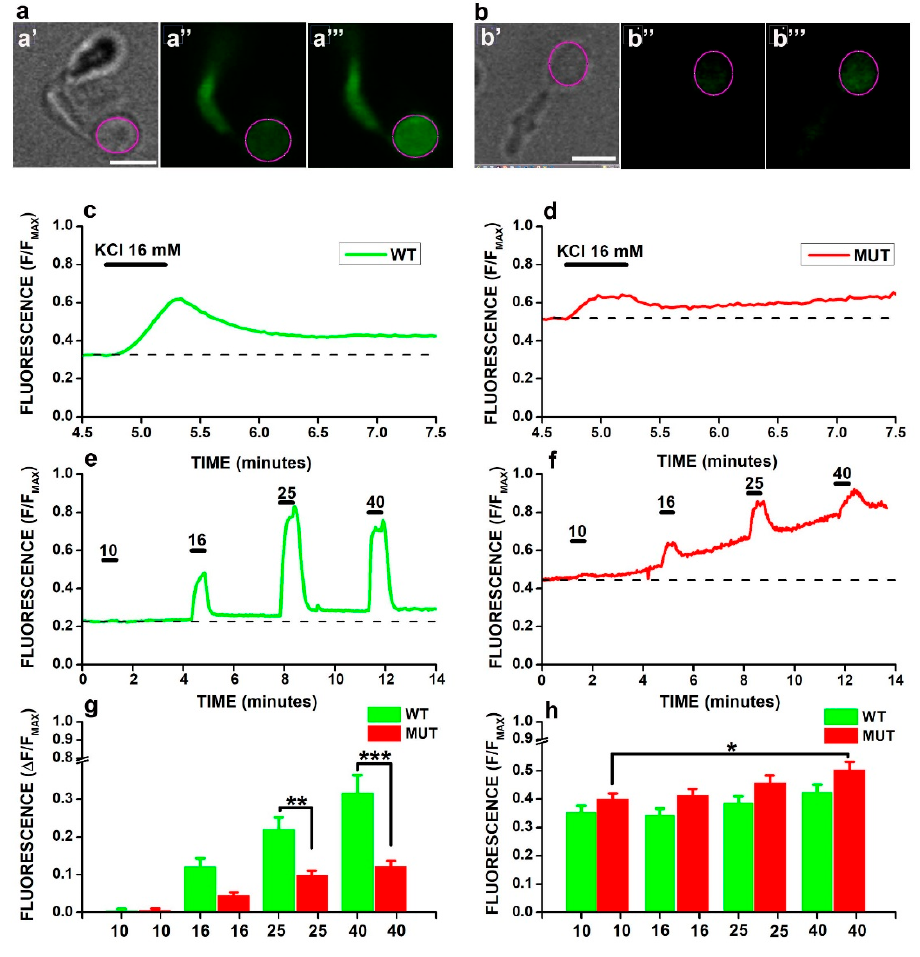
Figure 2. ( a , b ) Transmitted light images of isolated WT ( a (cid:48) ) and MUT ( b (cid:48) ) rods and Fluo-4 fluorescence in 3.6 and 16 mM KCl for a WT ( a (cid:48)(cid:48) , a (cid:48)(cid:48)(cid:48) ) and a MUT ( b (cid:48)(cid:48) , b (cid:48)(cid:48)(cid:48) ) rod, respectively. Calibration bars in a (cid:48) and b (cid:48) correspond to 5 µ m and hold for a and b panels, respectively. Magenta circles in a and b indicate the Region Of Interest (ROI) for fluorescence analysis. ( c , d ) Time-course of normalized fluorescence (F/F MAX ) over the region-of-interest of the cell body (magenta circles in ( a , b )) during a 30 s-long application (thick bars above records) of saline containing 16 mM KCl (black marks above records) for the WT ( c ) and the MUT ( d ) rod. Following exposure to 16 mm KCl, the F/F MAX value of WT and MUT rods did not recover to their baseline levels (dashed traces). ( e , f ) F/F MAX changes induced in the WT ( e ) and MUT ( f ) rods above by the application of saline with increasing [K] o concentrations of 10, 16, 25, and 40 mM. Time-course of application is indicated by black tick bars above the records. Note the progressive increase in F/F MAX above baseline (dashed lines) with additional stimulation by increased [K] o in both WT and MUT rods. ( g ) Bars plot mean (+SEM) net increases in normalized fluorescence ( ∆ F/F MAX ) induced by saline containing 10, 16, 25, and 40 mM [K] o in 34 WT (green) and 37 MUT (red) rods, respectively. Two-way ANOVA indicated significant effects of both genotype (F = 36.51412, with 1, 275 df: p = 4.91296 × 10 − 9 ) and [K] o (F = 31.05698, with 3, 275 df: p = 0). A post-hoc test with Bonferroni’s corrections for multiple comparisons indicated a significant reduction in MUT compared WT rods for [K] o 25 (t = 3.771, MSR = 0.01893; **, p < 0.01) and 40 (t = 5992, MSR = 0.01893; ***, p < 0.001) mM. ( h ) Bars plot the mean (+SEM) baseline fluorescence (before application of [K] o above 3.6 mM) for WT (green) and MUT (red) rods. The two-way ANOVA indicated significant effects of both genotype (F = 15.42187, with 1, 275 df: p = 1.08782 × 10 − 4 ) and [K] o (F = 5.95736 with 3, 275 df: p = 5.9971 × 10 − 4 ). The post-hoc analysis using Bonferroni’s correction for multiple comparisons indicated a significant baseline increase in MUT rods for baseline values before 40 vs. 10 (t = 3.052, MSR = 0.02036; *, p < 0.05) mM [K] o